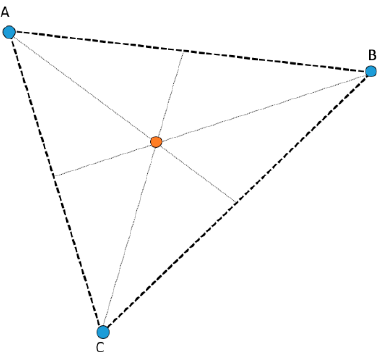
Figure 13. Symmetric point between points A, B, and C.